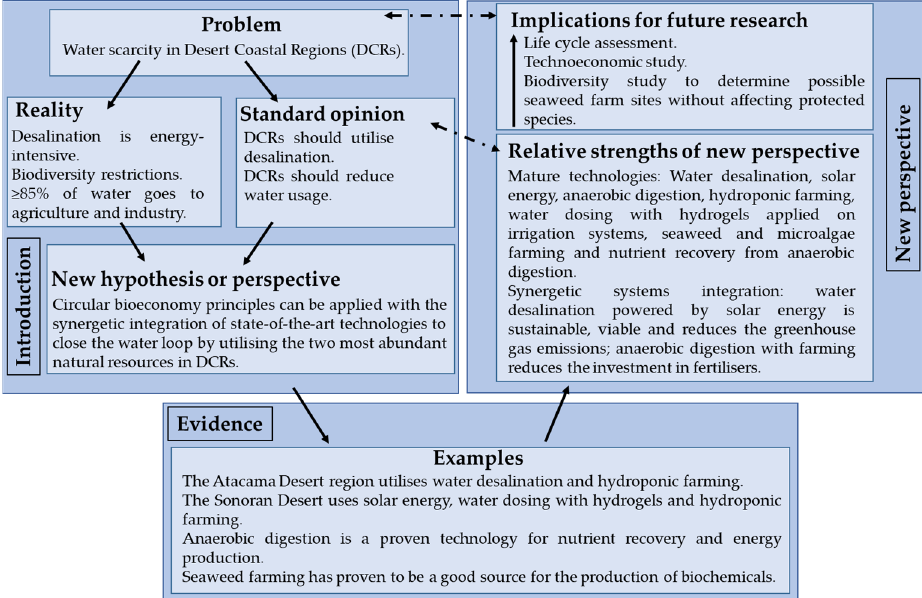
Figure 8. Scheme of the process followed in the article.